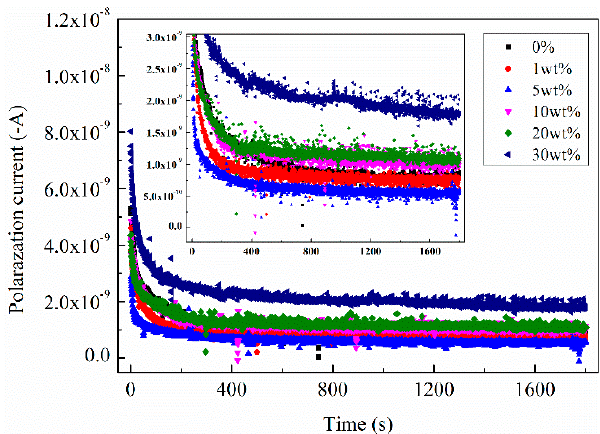
Figure 8. Polarization current in insulation sample under semi-conductive composites with different SrFe 12 O 19 contents.